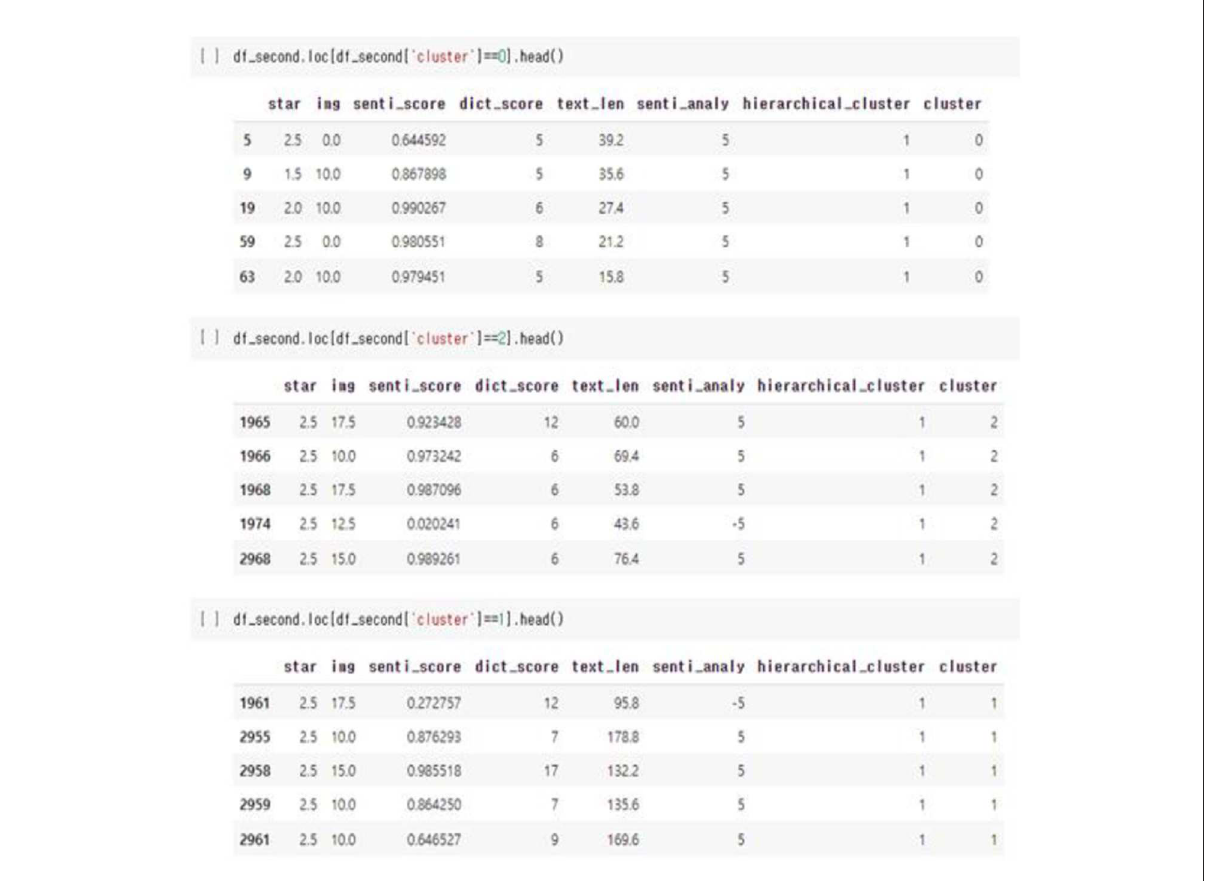
FIGURE12 Comments in different groups of cluster.